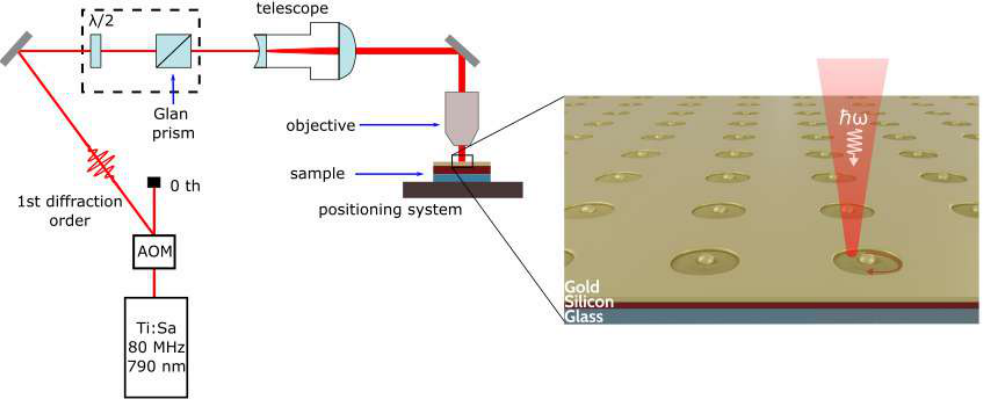
Figure 1. Schematic illustration of experimental setup used for particle fabrication. Inset illustrates a formation of hybrid nanoparticles array under femtosecond laser cutting of patch from a Au/Si bi-layer film on a glass